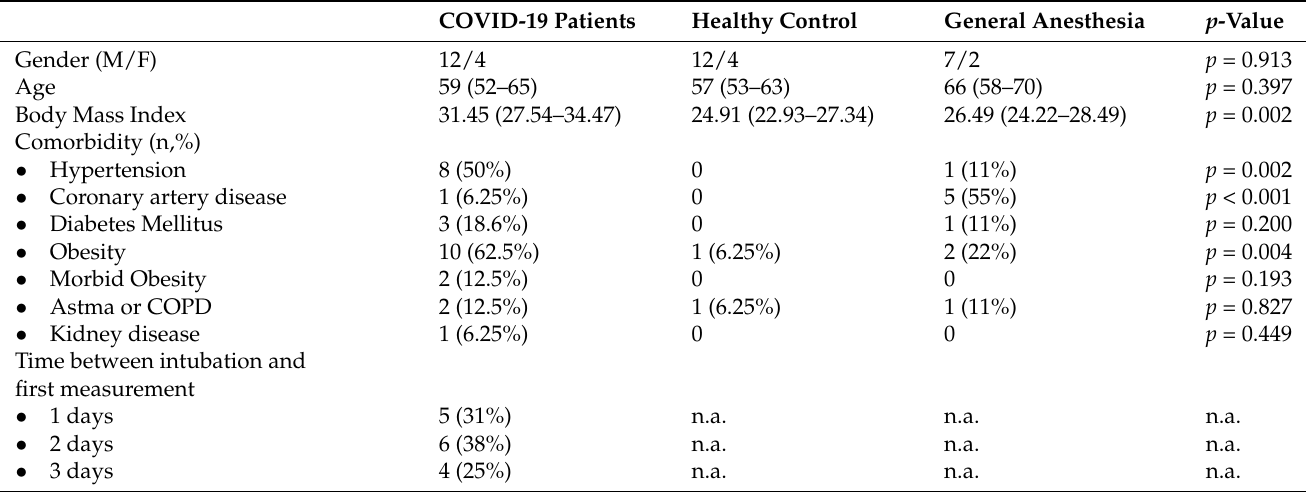
Figure 1. Flowchart of the inclusion process. Table 1. Baseline characteristics. Values are displayed as n (%) or median